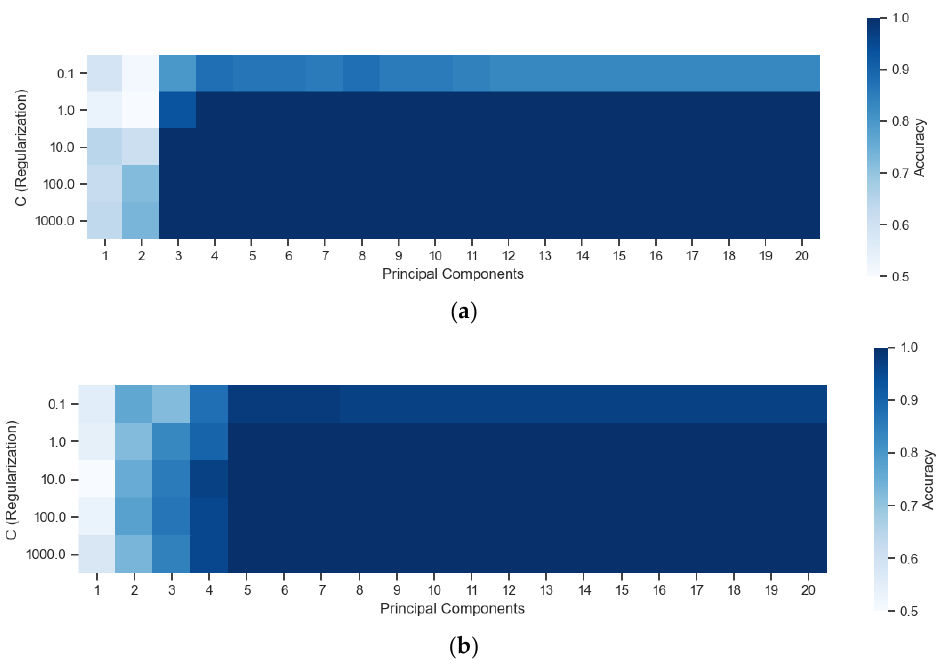
Figure 6. Optimization of the “Principal Components” and “C (Regularization)” parameters in the ( a ) UV region and ( b ) the VIS region for the SVM algorithm.